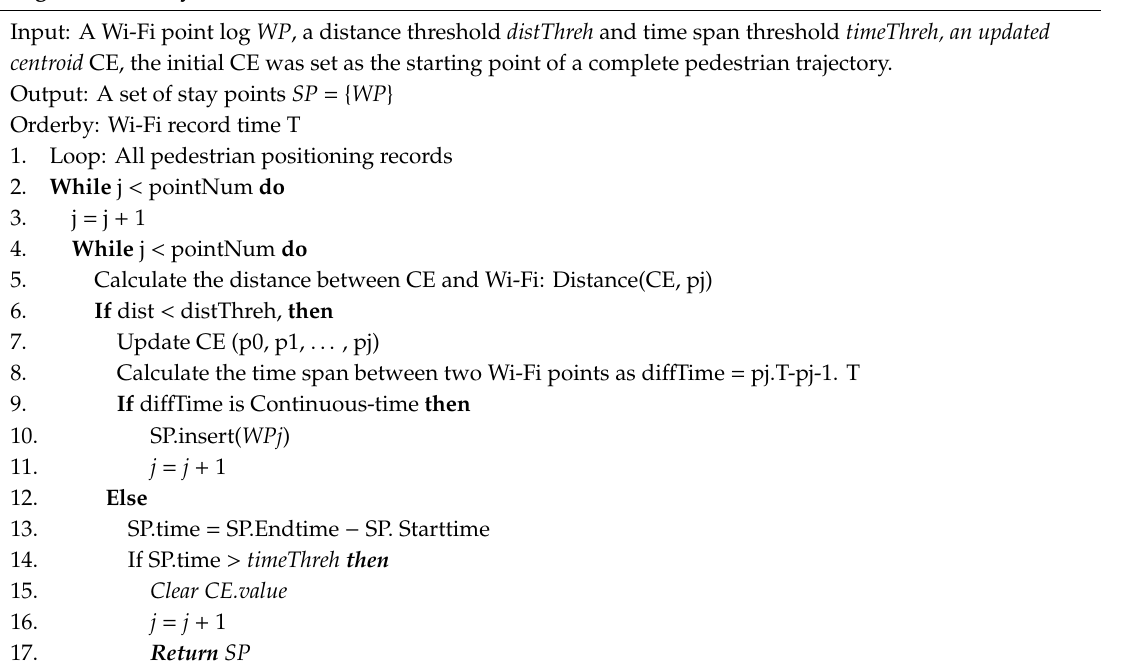
Algorithm 1: Stay Point_Detection (W P , distThreh , timeThreh,CE )